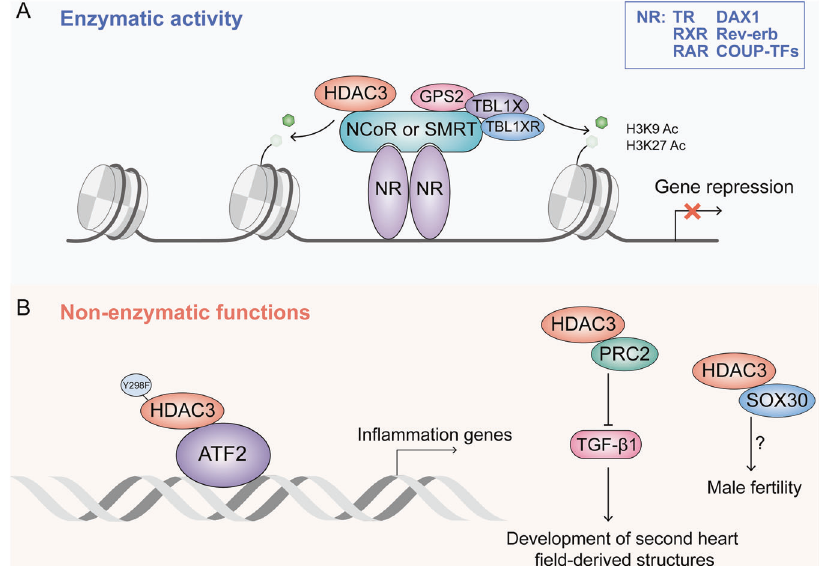
Fig. 2 The enzymatic activity and non-enzymatic functions of HDAC3. A HDAC3 is recruited to interact with NCoR or SMRT, forming nuclear receptor co-repressors complexes with G protein pathway suppressor 2 (GPS2), transducin β -like 1 (TBL1X), and TBL1-related protein 1 (TBL1XR). Co-repressors complexes binds to NR that have bound chromatin to perform transcriptional regulation dependent on its deacetylation function. B HDAC3 mutated in deacetylation sites directly binds to ATF2 to regulate transcription of in fl ammation-related genes independently of deacetylase activity. HDAC3 also can interact with PRC2 or SOX30 to regulates heart development and male